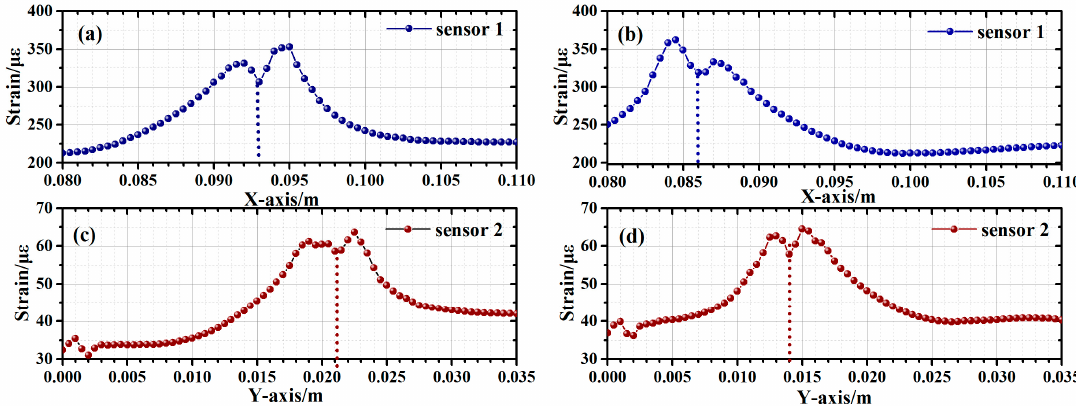
Figure 11. Inclined crack specimen non-uniform strain on X -axis 5 kN load: ( a ) Sensor1 Position 1; ( b ) Sensor1 Position 2; Y -axis 5 kN load: ( c ) Sensor2 Position 1; ( d ) Sensor2 Position 2.